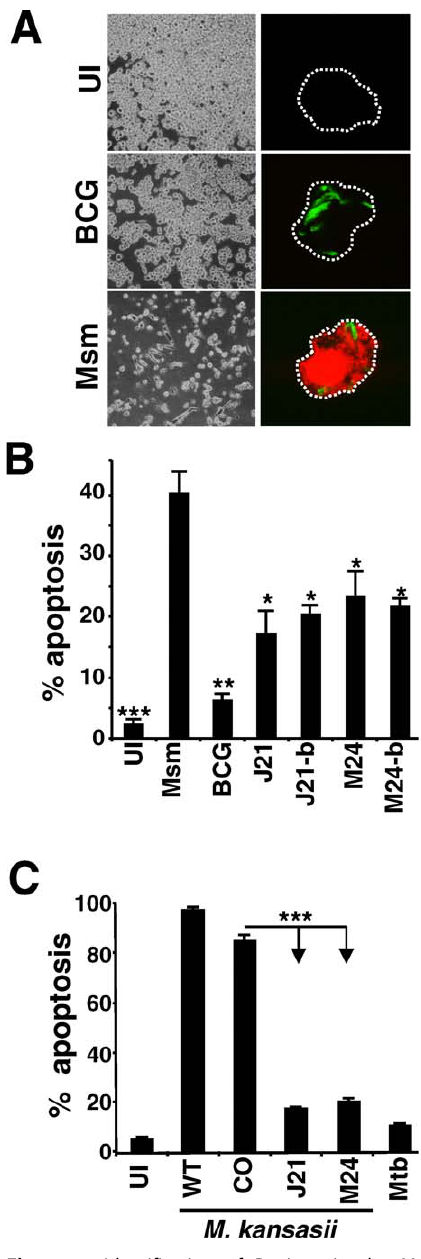
Figure 1. Identification of Regions in the Mtb Genome Mediating Inhibition of THP-1 Cell Apoptosis (A) M. smegmatis (Msm) induced more cell death in infected THP-1 cells than BCG or uninfected cells (UI) as observed by bright field microscopy (left panels) and fluorescence microscopy of TUNEL staining (right panels; red fluorescence is TUNEL staining, and green fluorescence